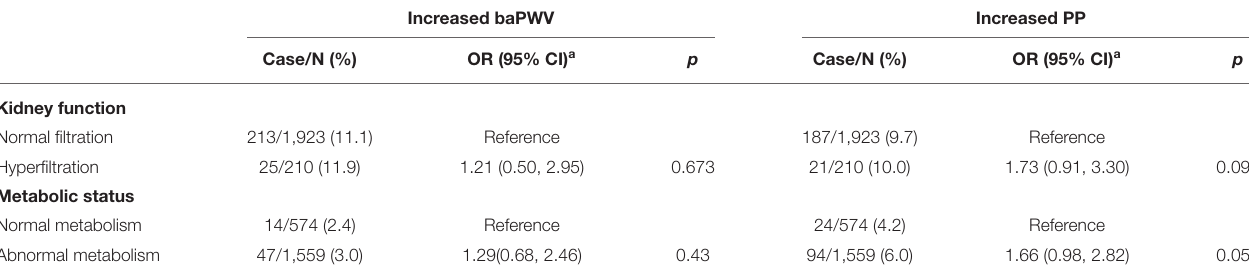
TABLE 2 | Association between hyperfiltration/abnormal metabolism and outcomes in all participants.